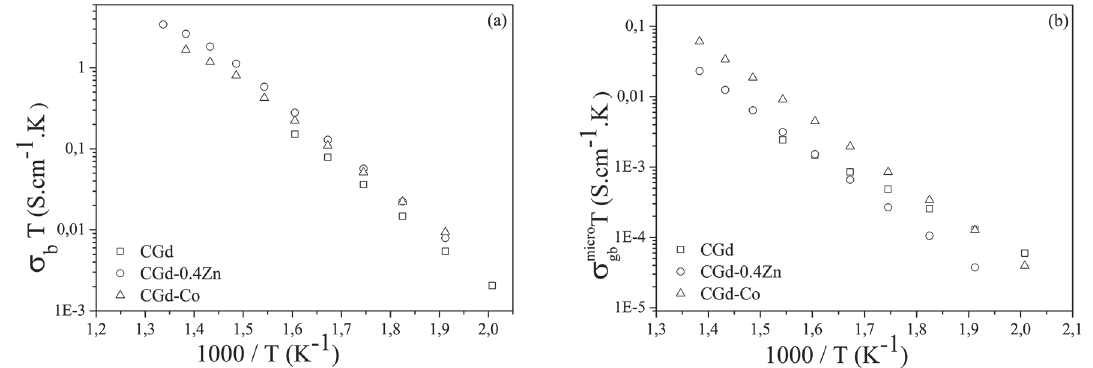
) and microscopic grain boundary (E ab